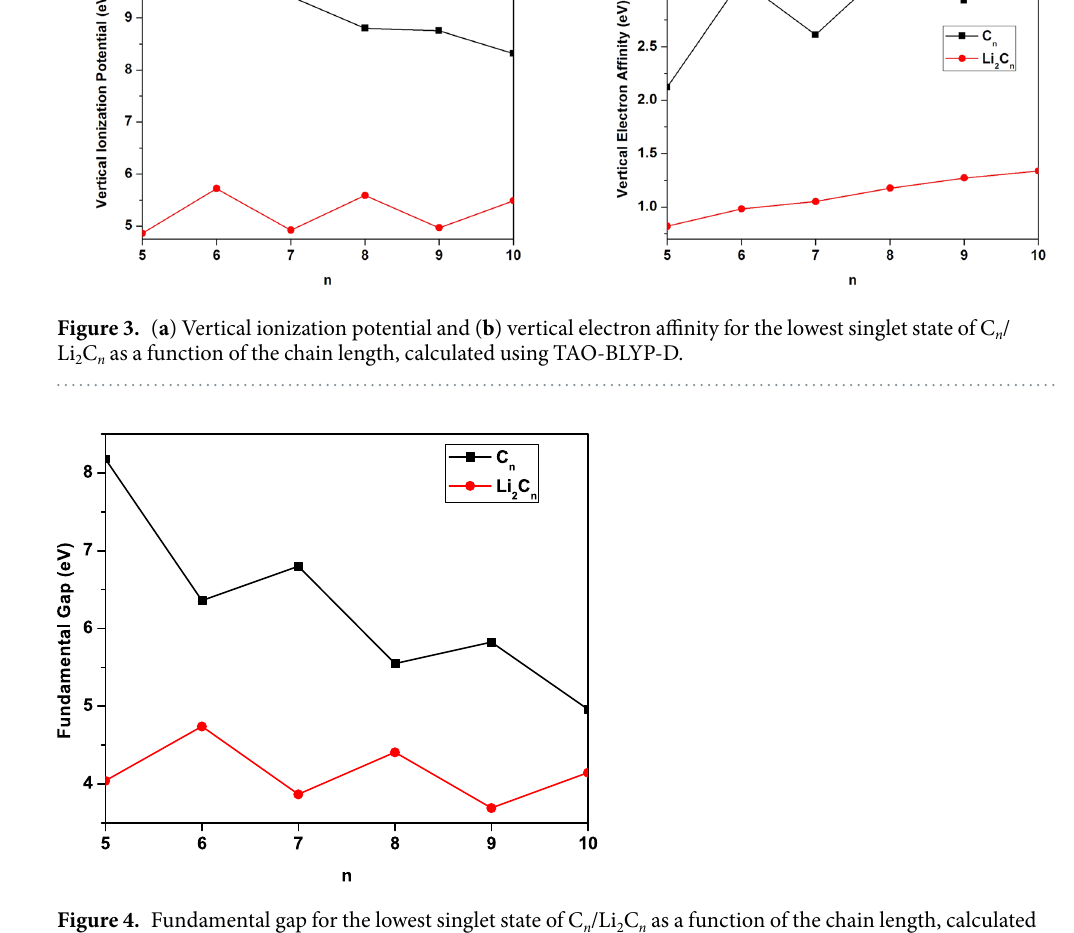
Figure 4. Fundamental gap for the lowest singlet state of C n /Li 2 C n as a function of the chain length, calculated using